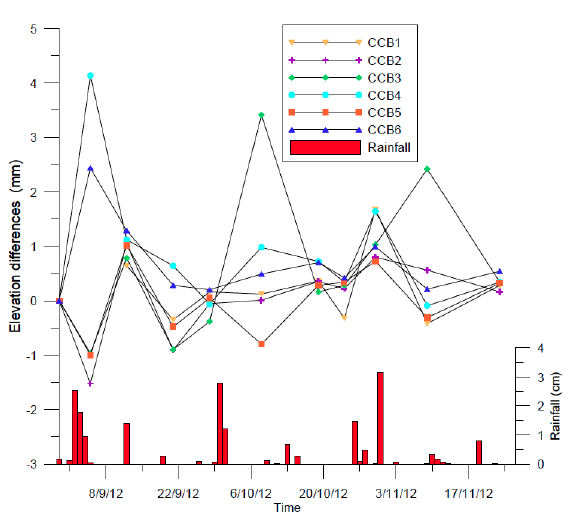
Figure 4. Elevation differences between two contiguous